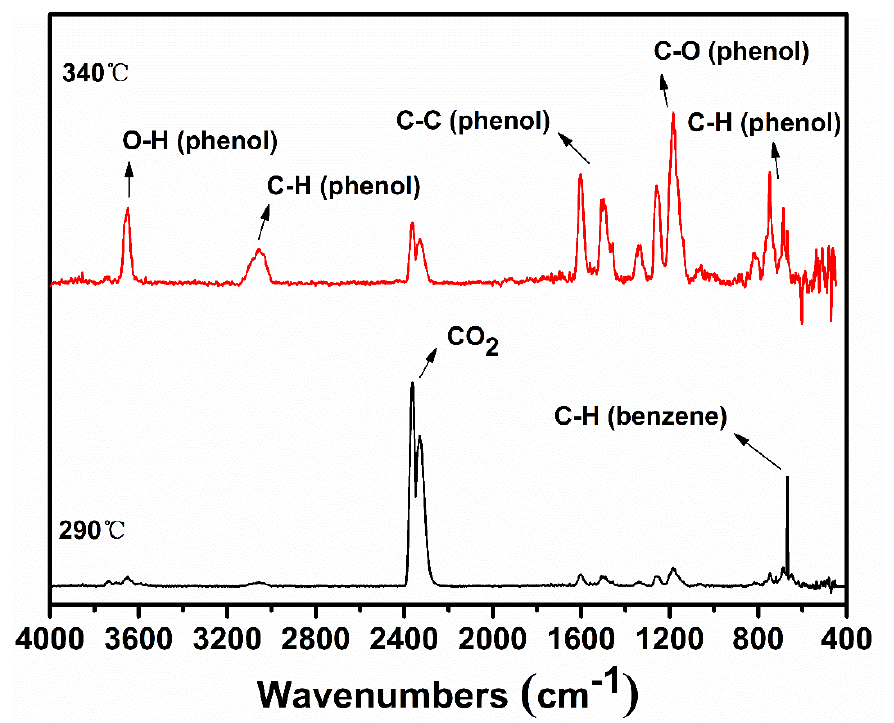
Figure 8. FTIR spectra of gaseous products of sodium salicylate at selected temperatures in the first decomposition step.